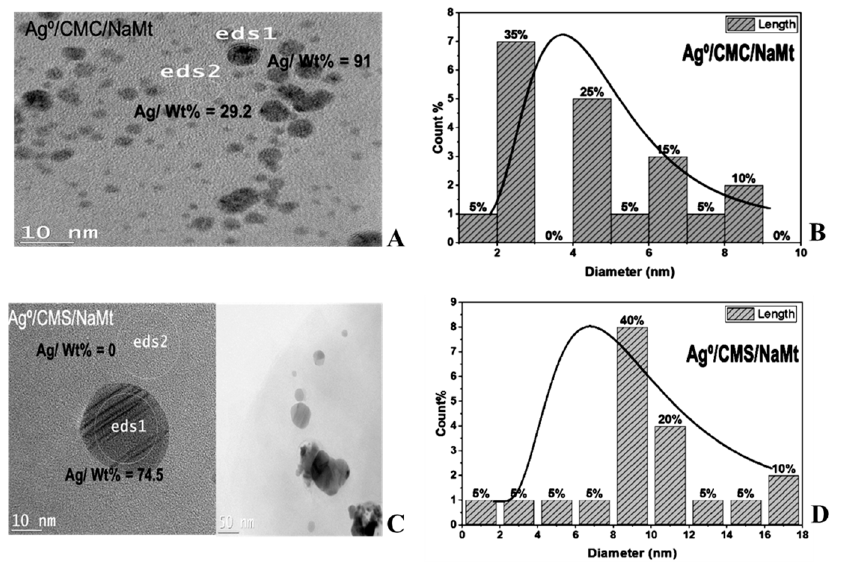
Figure 5. TEM images and Ag 0 particle size distribution in CMC/NaMt ( A , B ) and CMS/NaMt ( C , D ).